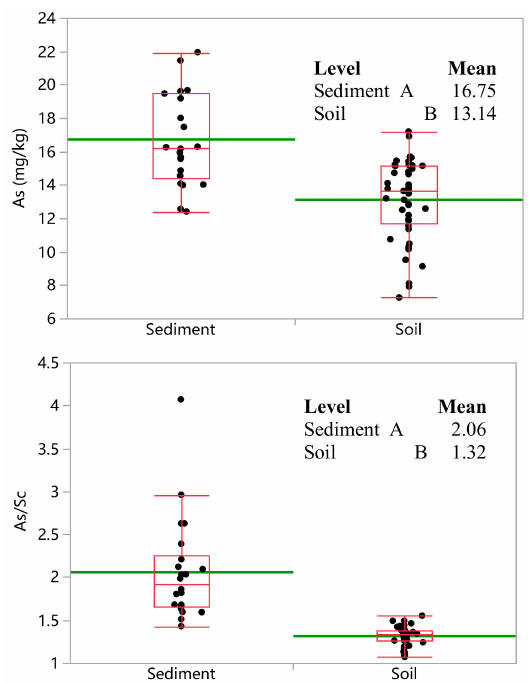
Figure 4. Comparisons of As levels and As/Sc ratio in the lake sediment and soil around the lake. 3.3. Relationships between As and Other Elements in the Water, Sediment, and Soil The results of correlation analysis between As and other elements in the water, sedi- ment, and soil are shown in Table 3. The significantly positive correlation between As and B concentrations was observed in the river water ( p < 0.01), lake water ( p < 0.01), and pore water ( p < 0.05). Our previous study reported that the geochemical process of B in Lake Qinghai was characterized by evaporative concentration and reductive release [10], which was similar to that of As in the present study. Arsenic concentration was significantly ( p < 0.01) positively correlated with concentrations of V, Sc, P, S, Cl, Mn, Fe, Mg, and Ca in the lake water rather than in the river water and pore water. This might be caused by evaporative concentration. Sodium and Cl are the conservative elements and can be used to indicate the level of evaporative concentration [29,30]. The high concentration of Na + and Cl − in the lake water (Table 2) and their significantly positive correlation with As concentration (Table 3), therefore, further demonstrated that the higher As concentration in the lake water was related with the evaporative concentration